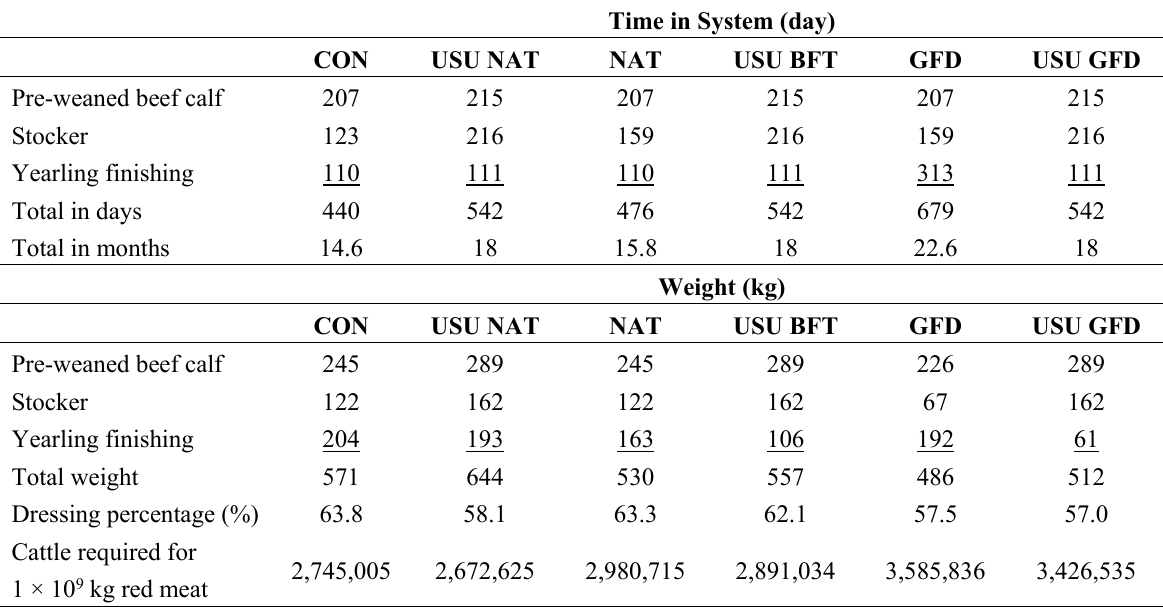
Table 1. Capper [62] calculated the number of days to slaughter, final weights, dressing percentage and the number of cattle required to produce 1 billion kg beef for three